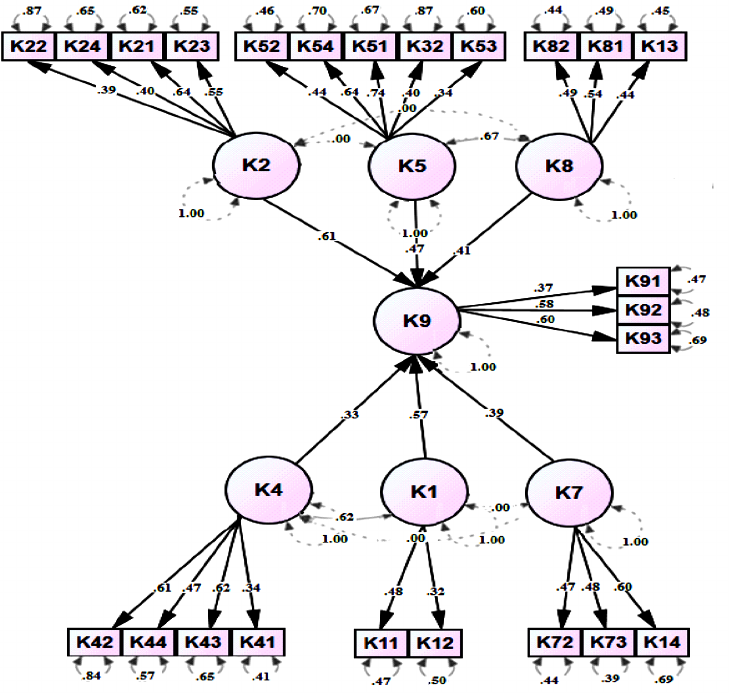
Figure 2. Structured model with standardized path estimates (source: own